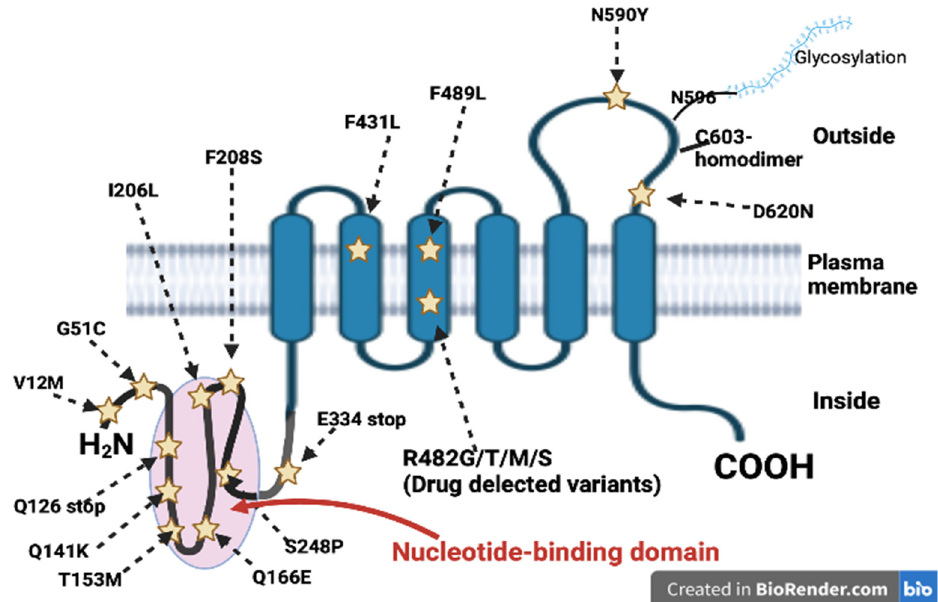
Figure 2. Schematic representation of ABCG2 proteins and its variants. Stars identify single-nucleotide polymorphisms. Abbreviation: NBD: Nucleotide-binding domain.